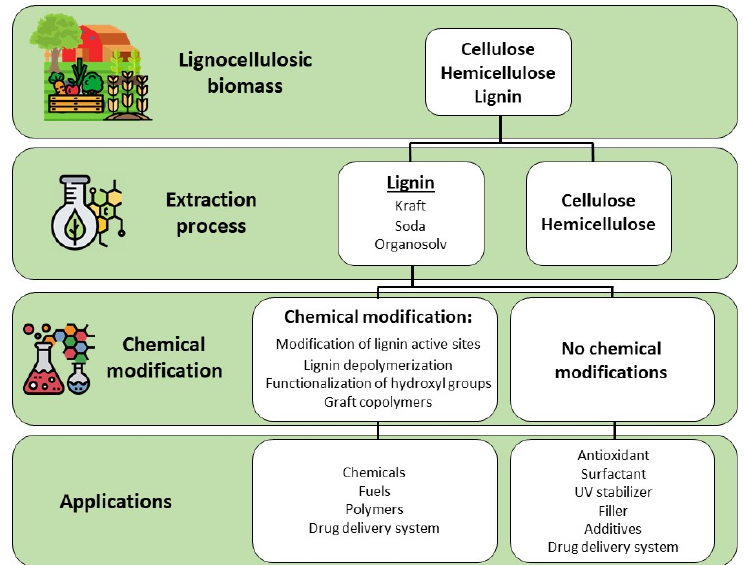
Figure 5. Schematic overview of lignin recovery, extraction, modification and applications.